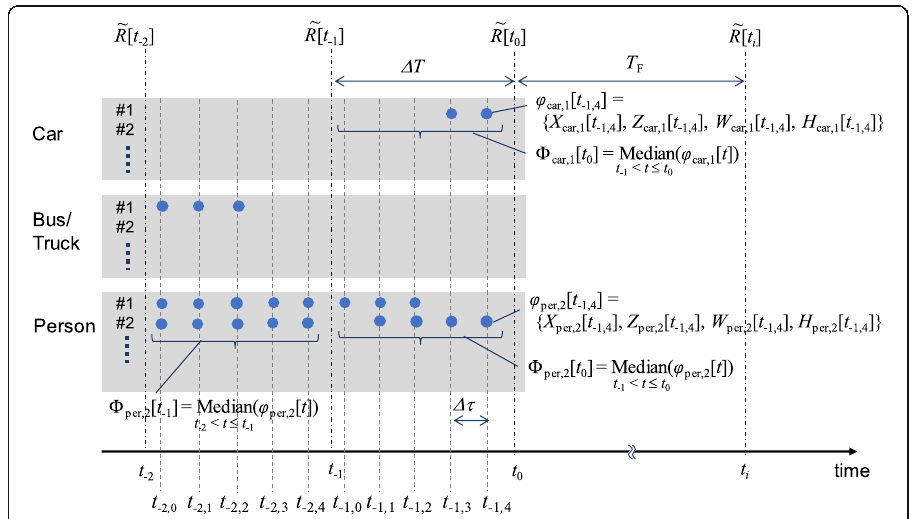
Fig. 2 Diagram of object bounding-box information and the time intervals for Δτ = Δ T /5. The object